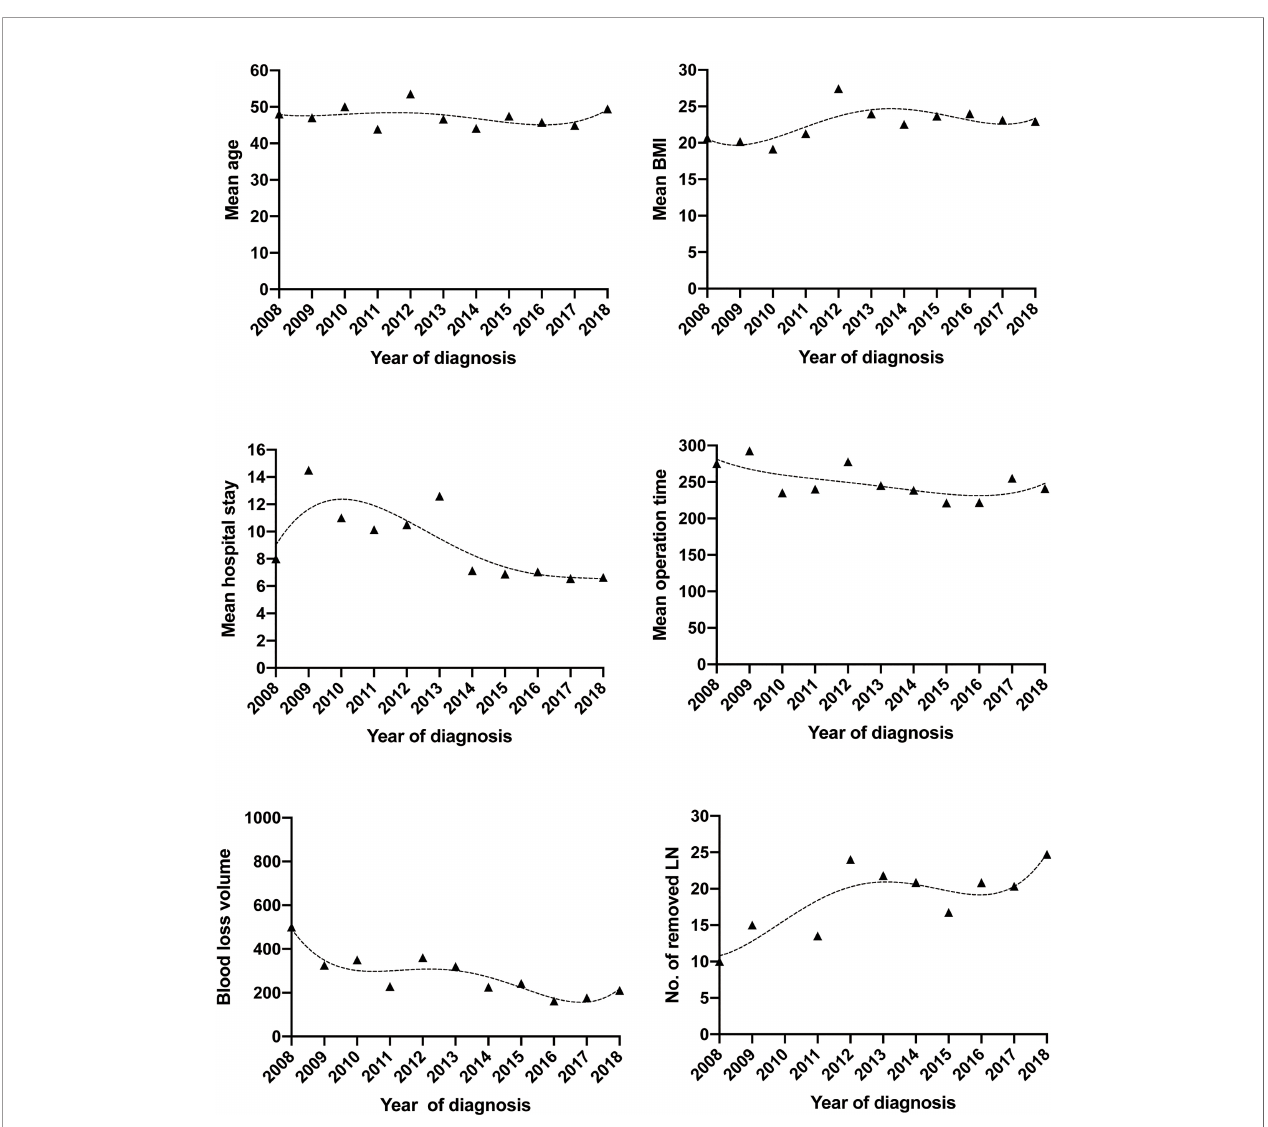
FIGURE 3 | Trends of demographics and surgical morbidities with MIS approach of early-stage cervical cancer over the past 11 years. MIS, minimally invasive